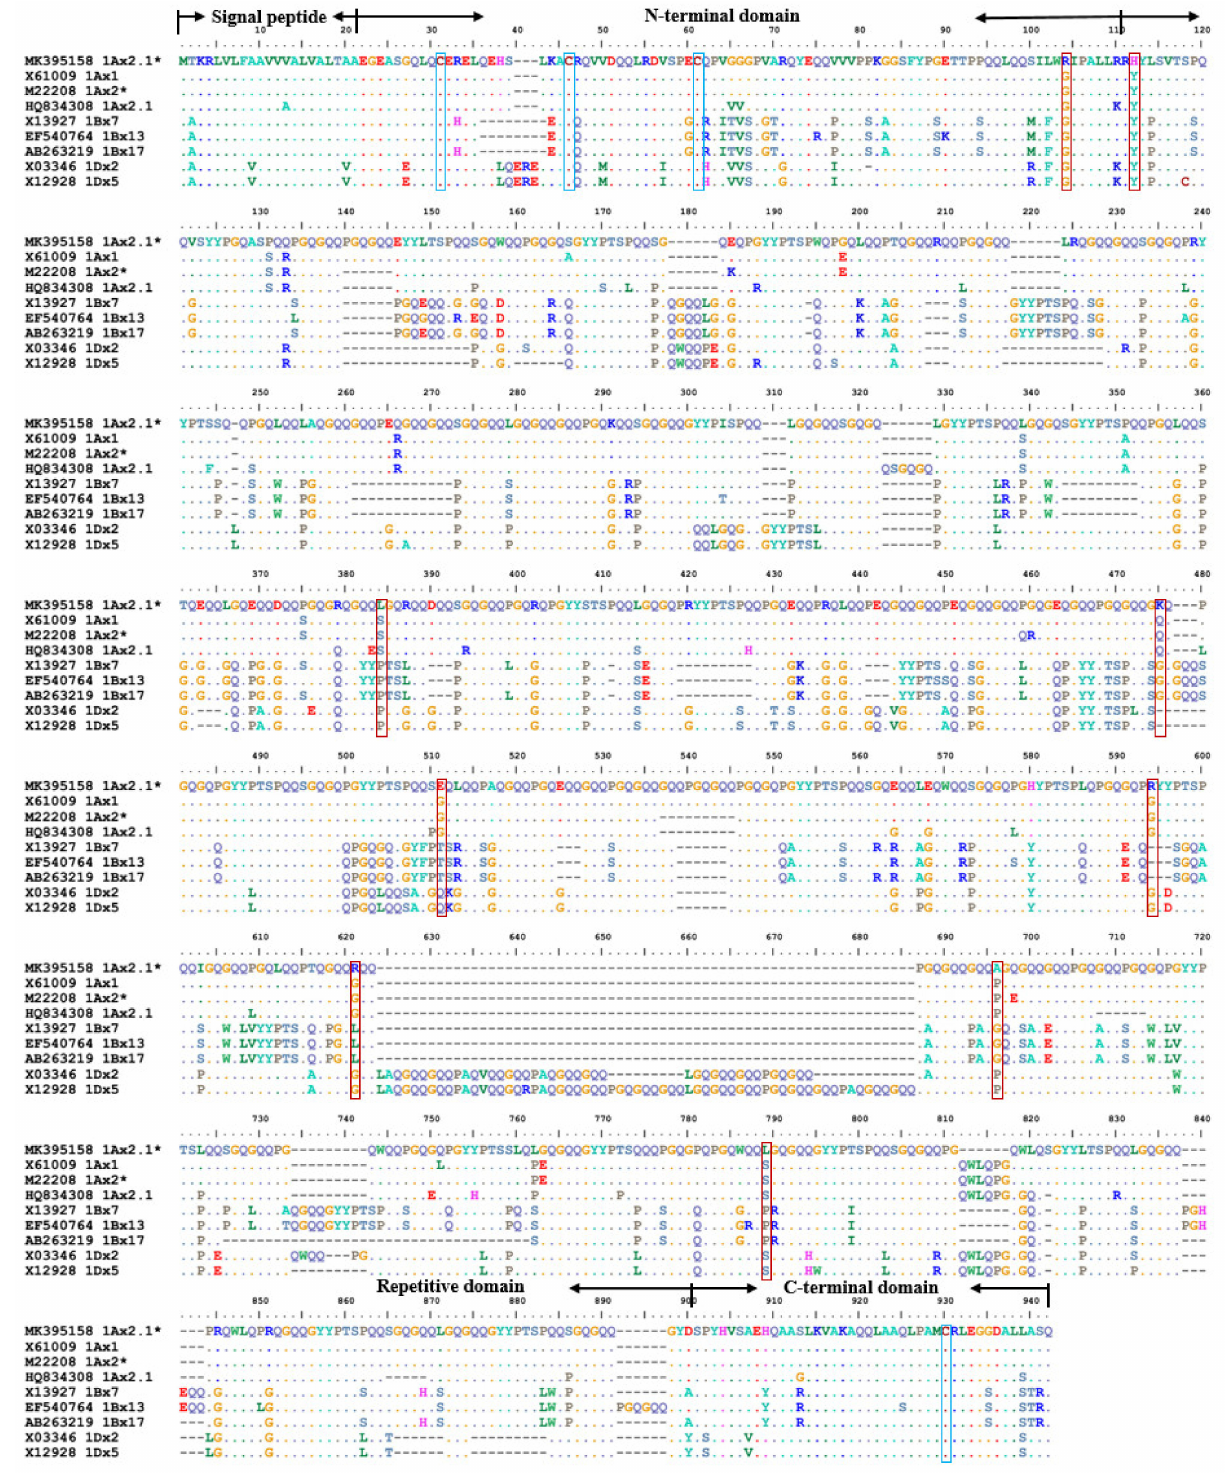
Figure 2. Comparison of the deduced amino acid sequences of 1Ax2.1* gene from spelt wheat with other eight x-subunit genes. The blue boxes indicate the cysteine residues, red boxes indicate differences of amino